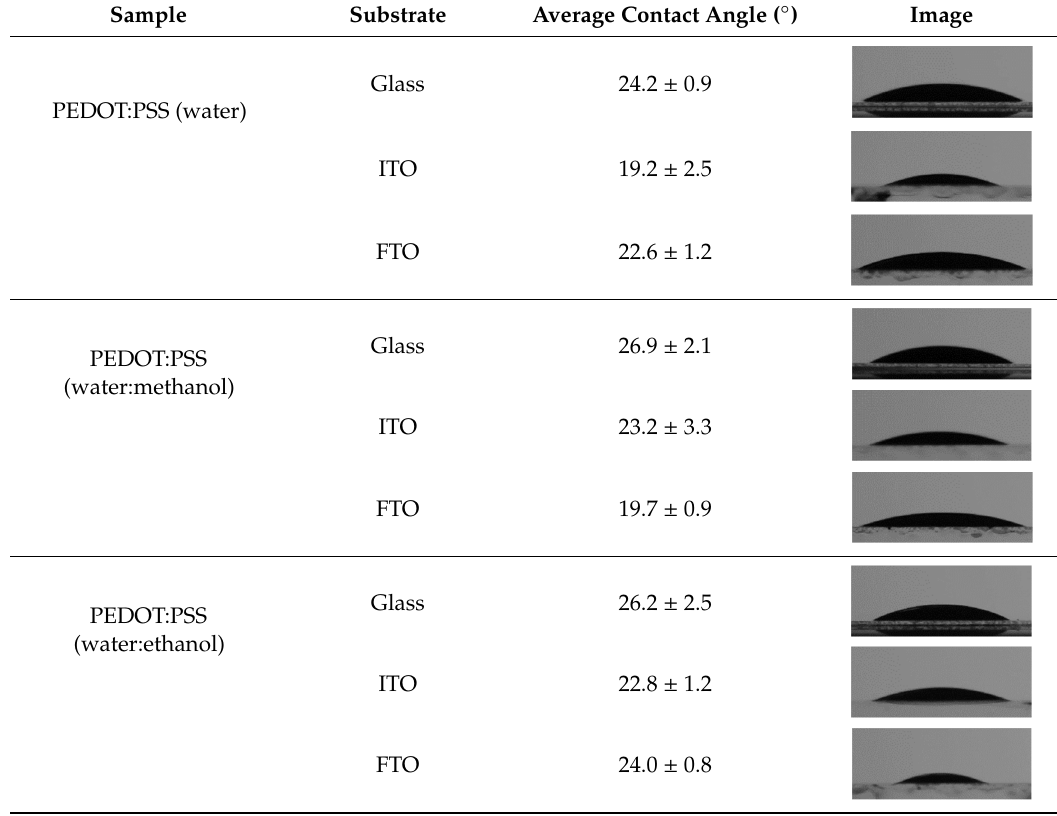
Table 1. Contact angle results for three different surfaces (glass, glass/indium tin oxide (ITO) and glass/fluorine-doped tin oxide (FTO)) for aqueous-based PEDOT:PSS solutions with and without alcohol. Sample